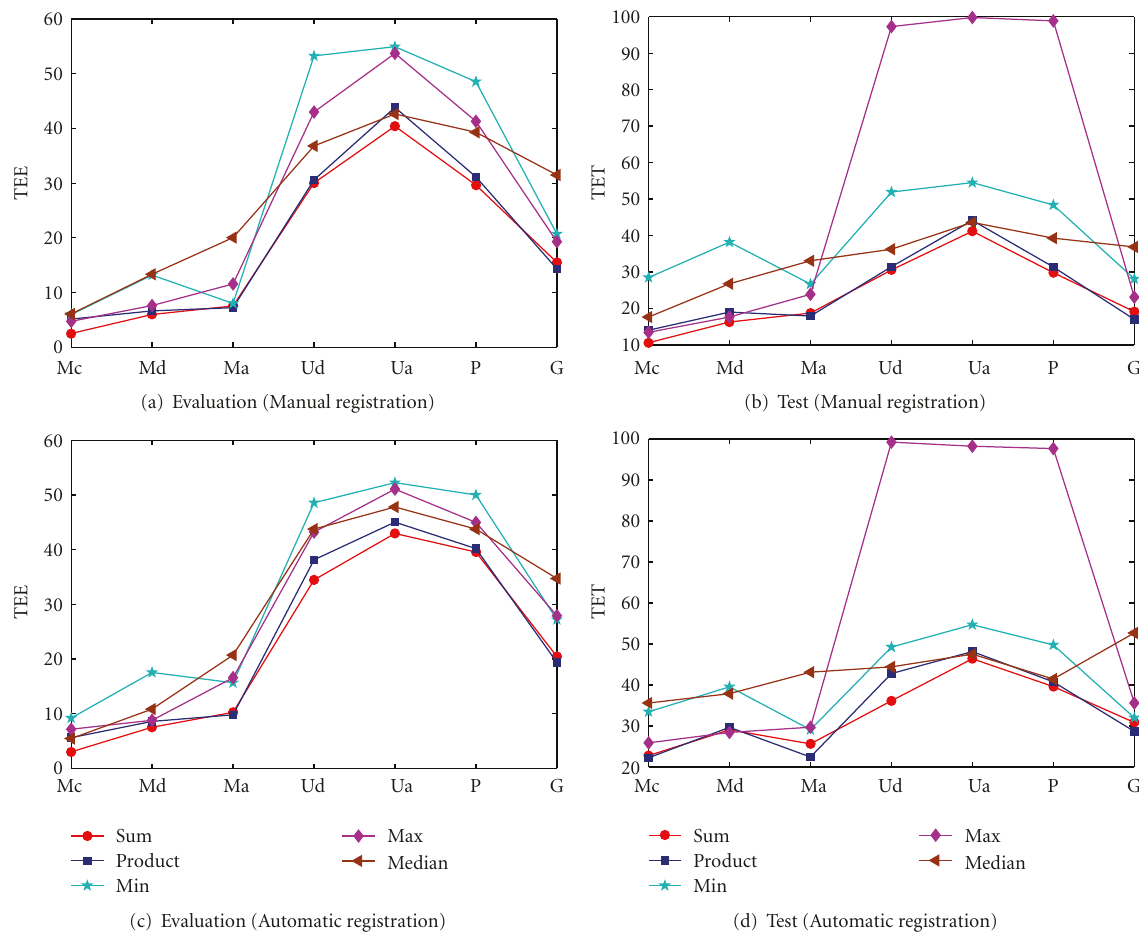
Figure 4: Untrained fusion results in the evaluation and test steps for di ff erent BANCA experimental protocols.